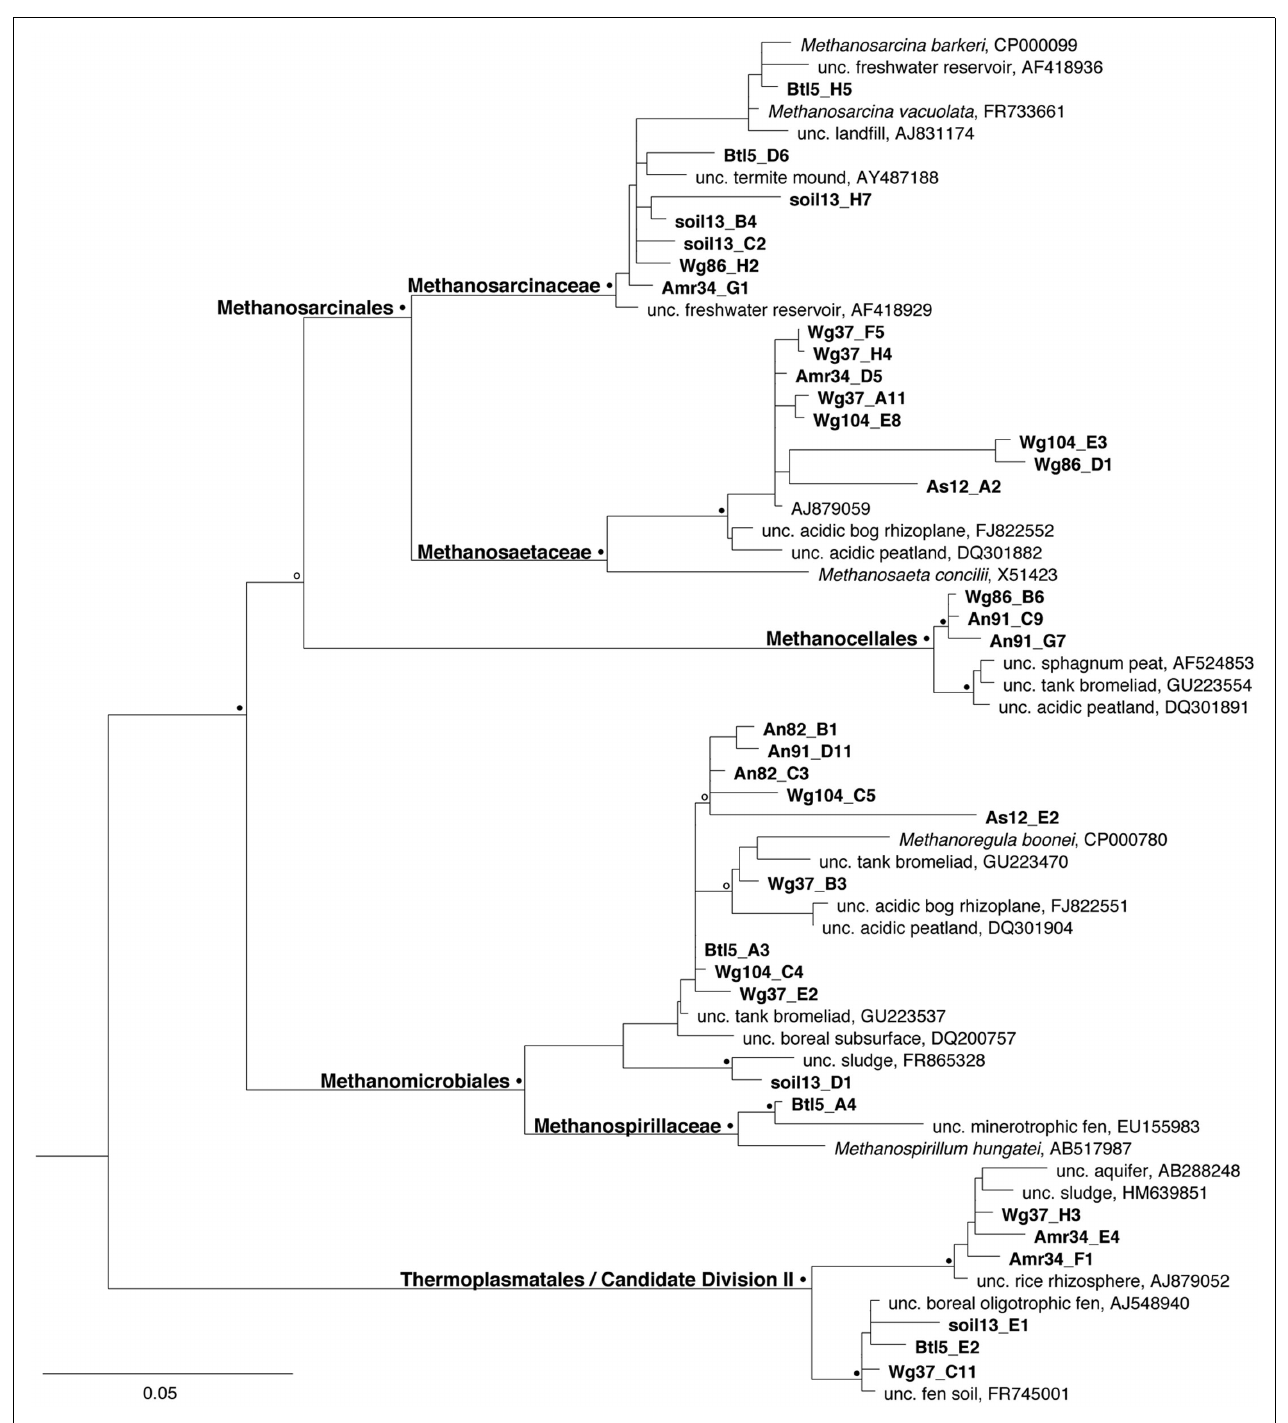
uncultured member of the Korarchaeota (DQ465910) as an out group (not shown).The symbols at the nodes represent bootstrap values from a Kimura-2 parameter neighbor-joining analysis obtained from 2000 replicate samplings (open symbol = 70–80%, closed symbol = 80 + % bootstrap support). Sequences obtained in this study have been deposited in the GenBank database under accession numbers